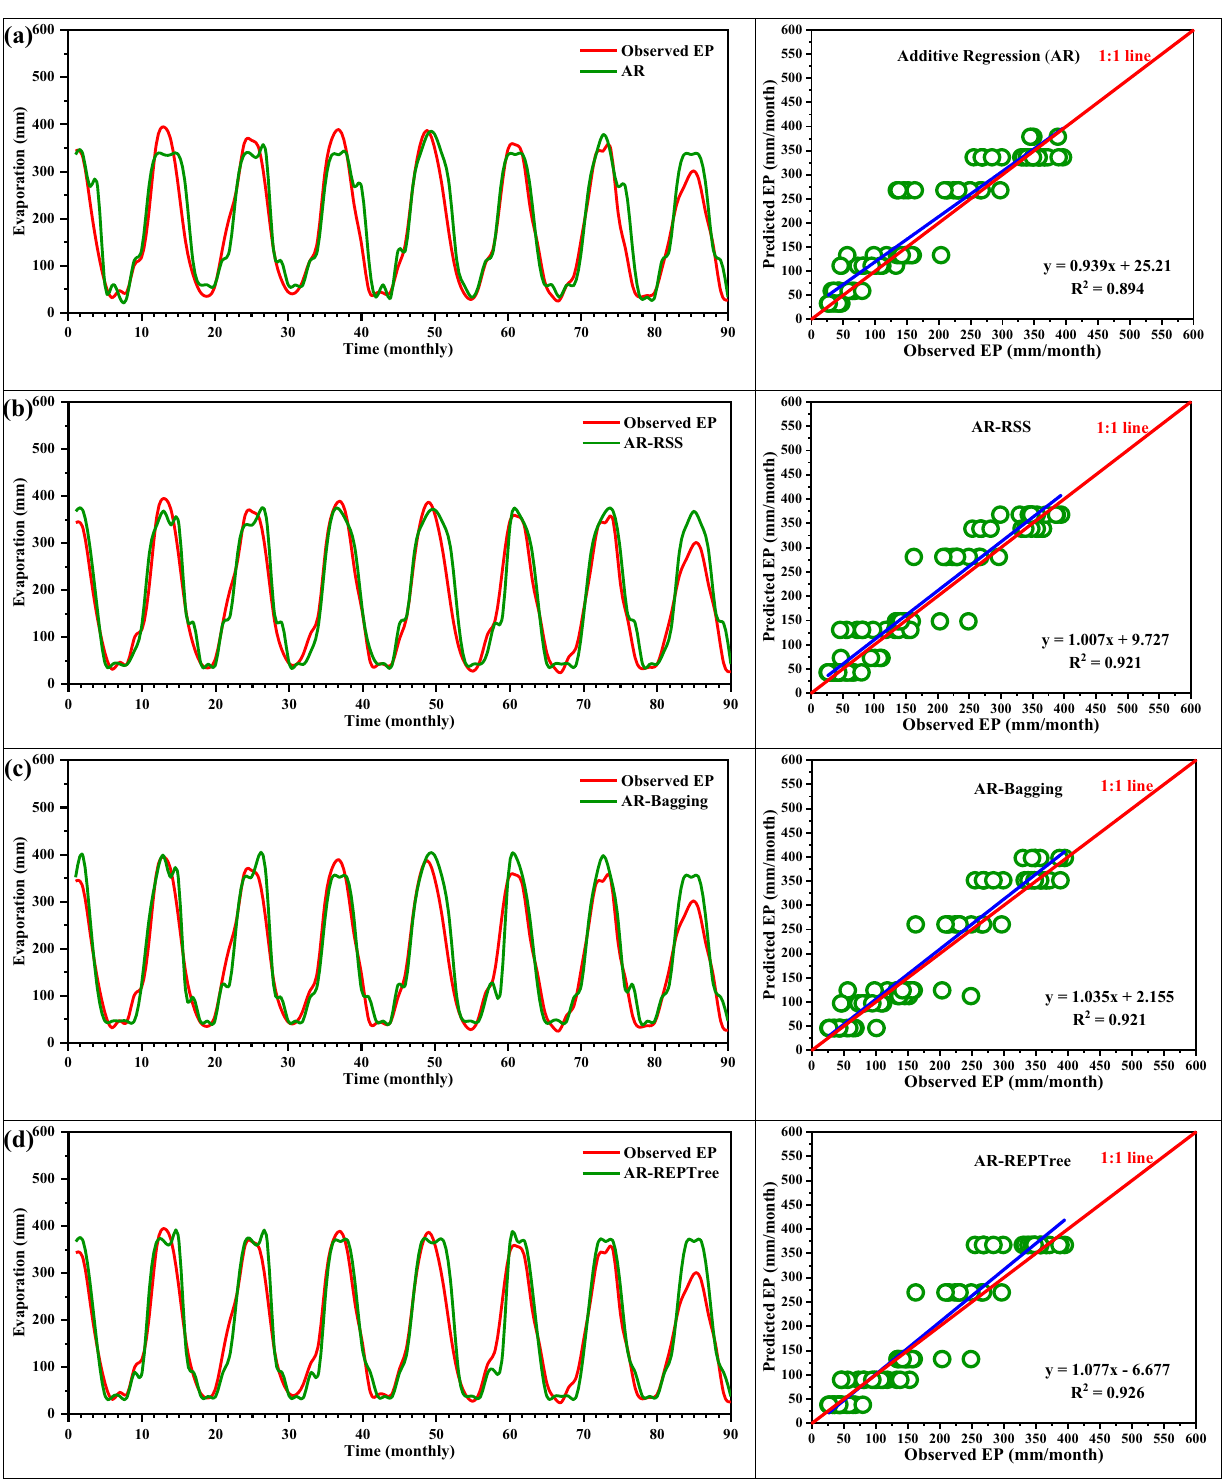
Fig. 8 Observed vs estimated daily evaporation values by the AR, AR-RSS, AR-Bagging, AR-REPTree, and AR-M5P models during testing at Mosul